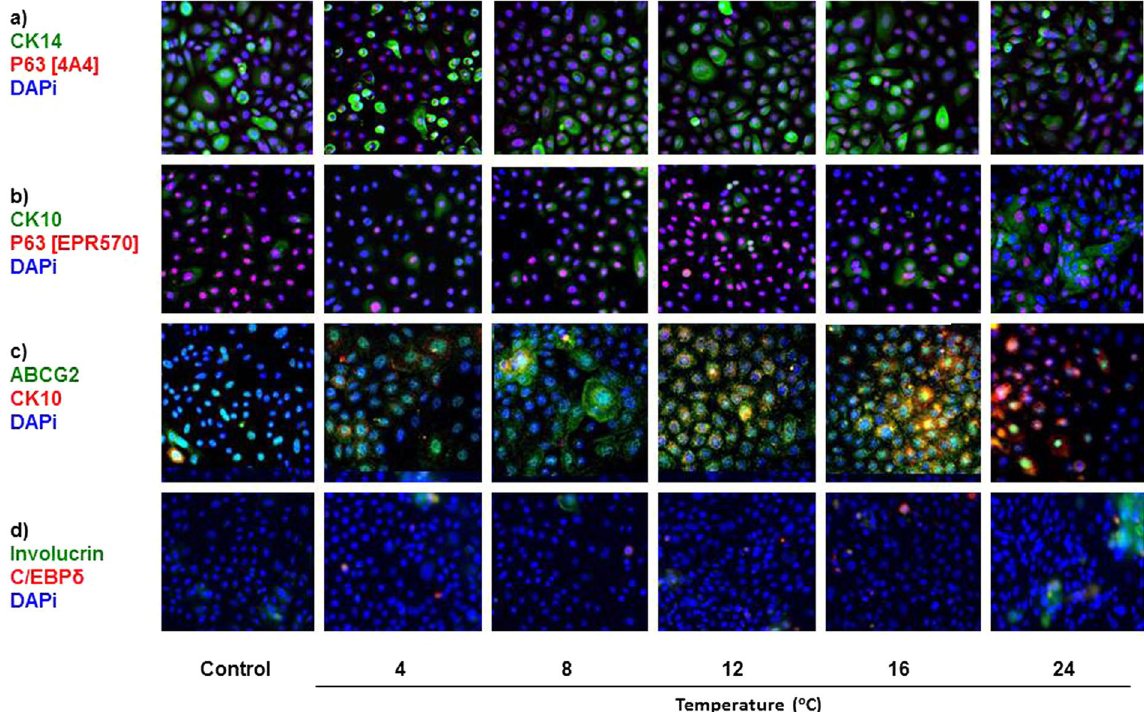
Figure 6. Immunocytochemistry using putative epidermal stem cell and differentiated epidermal cell markers. Figures show comparison of non-stored control with storage temperature groups. Magnification: 200X.